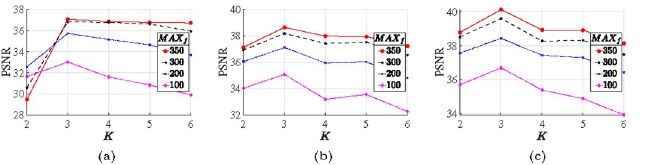
Fig 2. Evolution of PSNR values of denoised images with MAX sizes. (a): “beauty” image; (b): “lotus” image; (c): “dolphin” image.